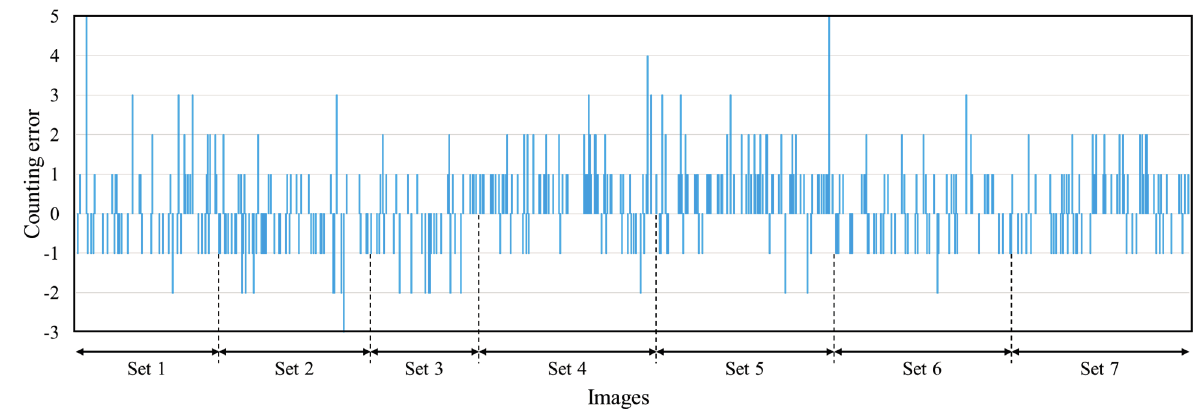
Figure 7. Tree counting errors in 941